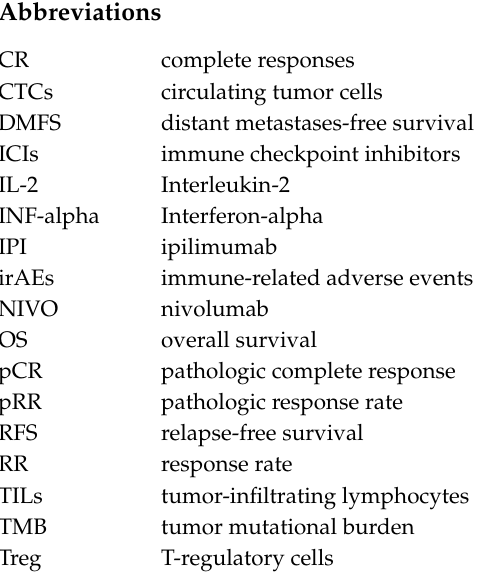
Table S1: Ongoing neoadjuvant clinical trials in melanoma, Table S2: Search query on clinicaltrial.gov: